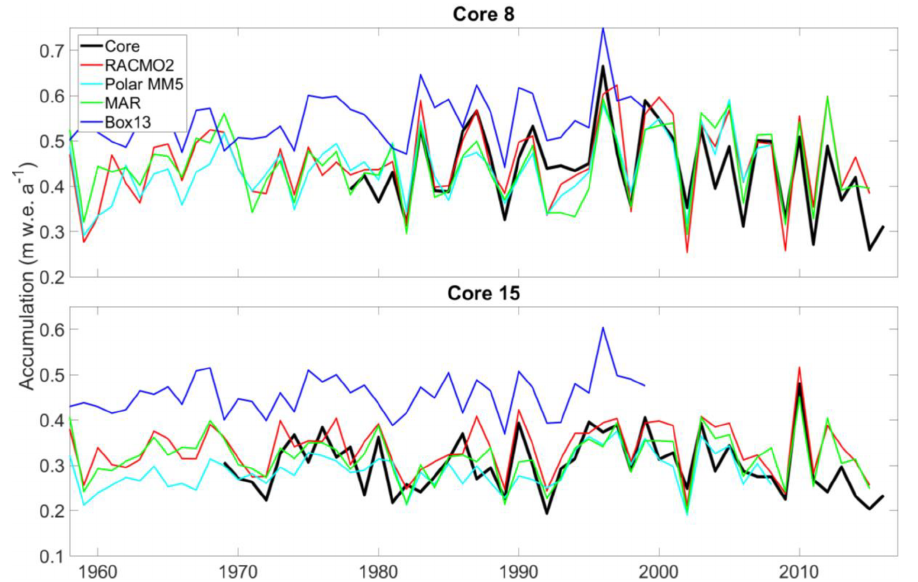
Figure 8. Accumulation record at GreenTrACS Core 8 and Core 15 (black) compared with RCM output from RACMO2 (red), Polar MM5 (cyan), MAR (green), and Box13 (blue). We find statistically significant Pearson correlation coefficients between GreenTrACS and RCM accumulation rates for these cores (see Table